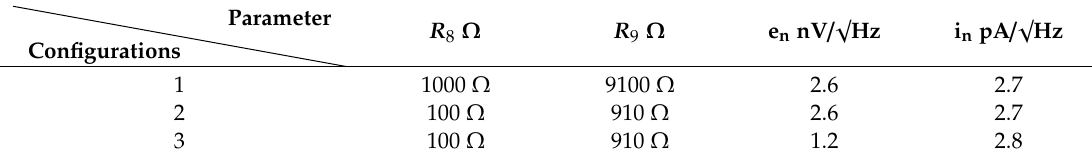
Table 2. Simulation parameters of the preamplifier.